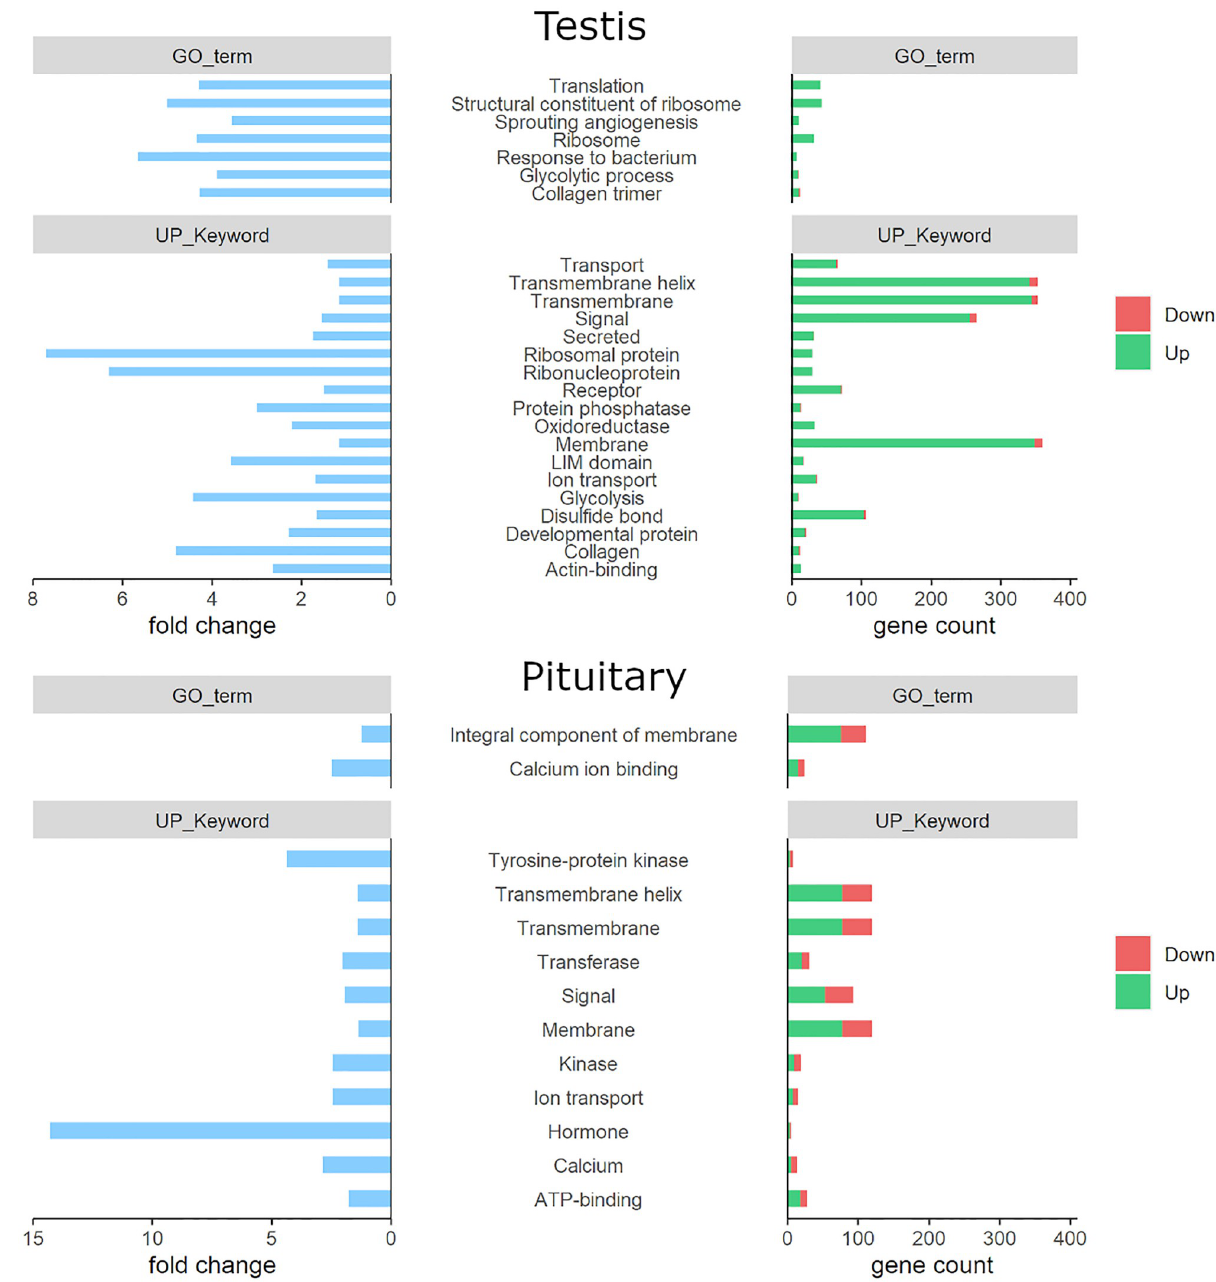
Fig 5. Pathway enrichment with DAVID. Pathway enrichment analysis results displayed as gene count and fold change. All pathways shown here are significantly enriched in the DEG dataset (Bonferroni corrected p-value < 0.05).